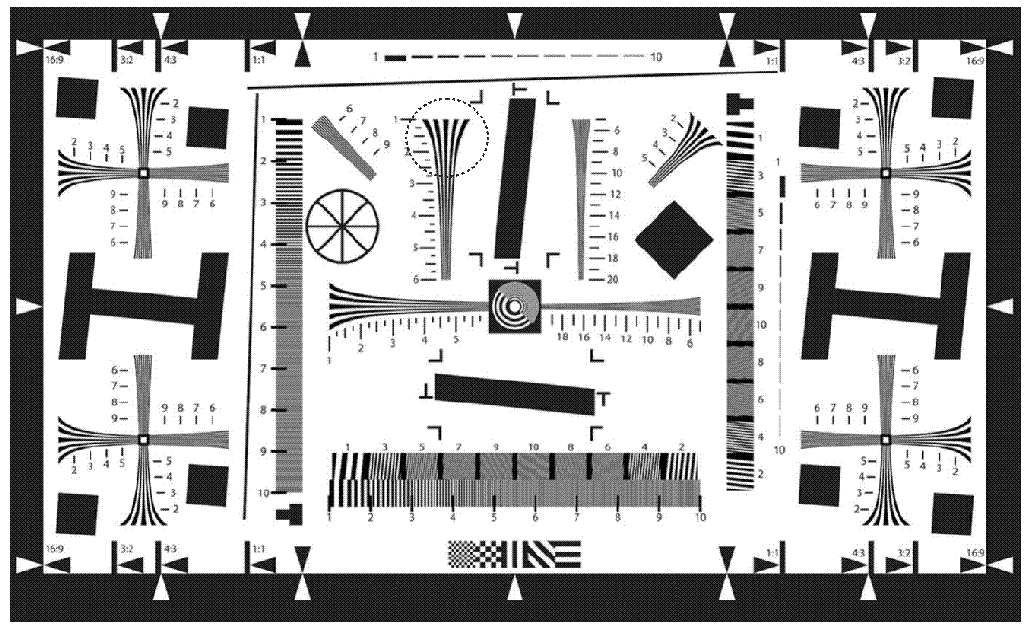
Figure 12. A black-and-white test pattern for testing lenses.